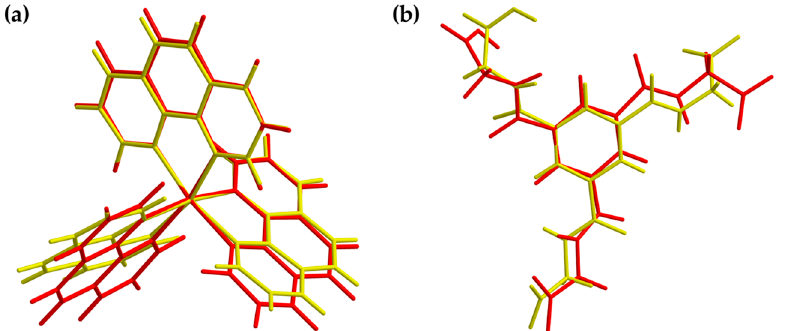
Figure 10. Overlay view of the structures in the crystal (yellow) and optimized structures (red) of the